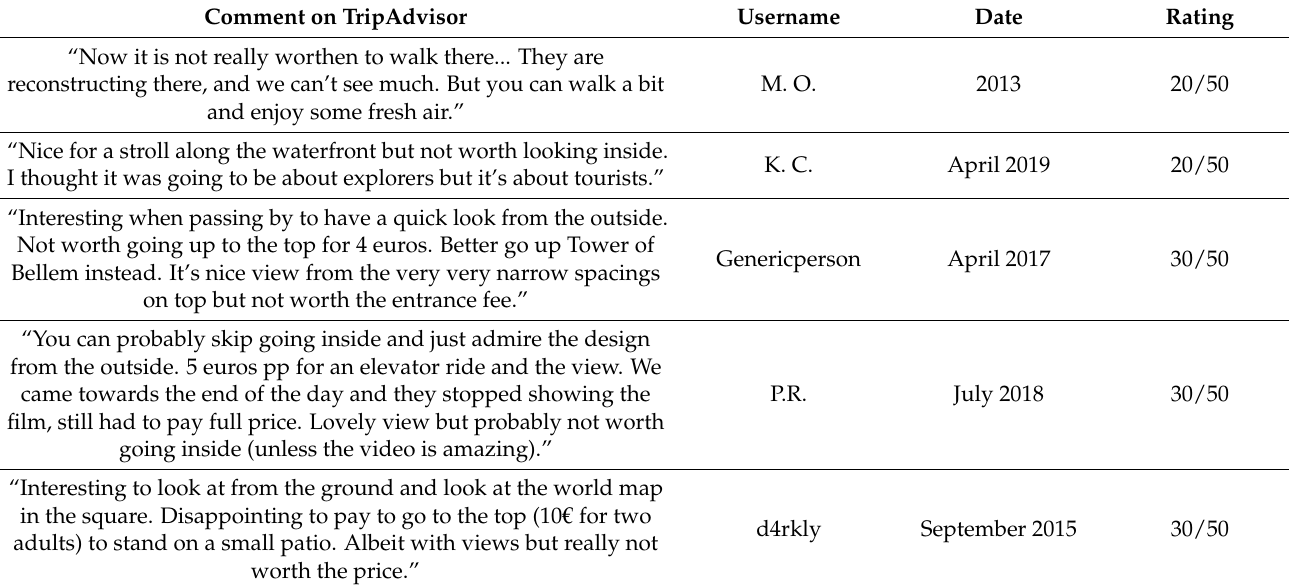
Table 3. Quotations that manifest the preference for outside visits instead of entering the Padr ã o dos Descobrimentos.